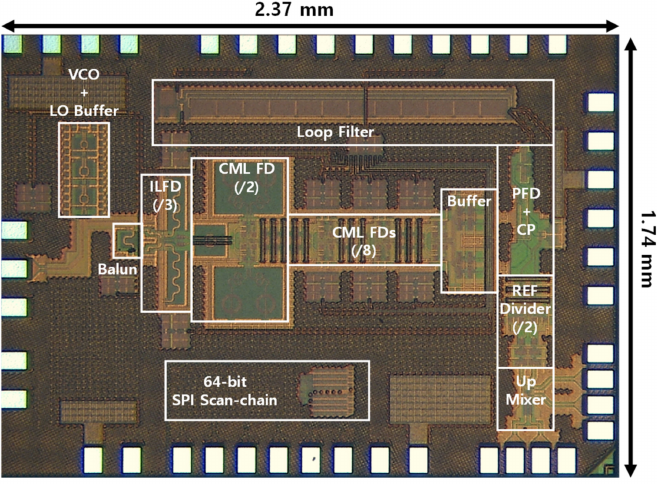
Figure 13. A microphotograph of the proposed